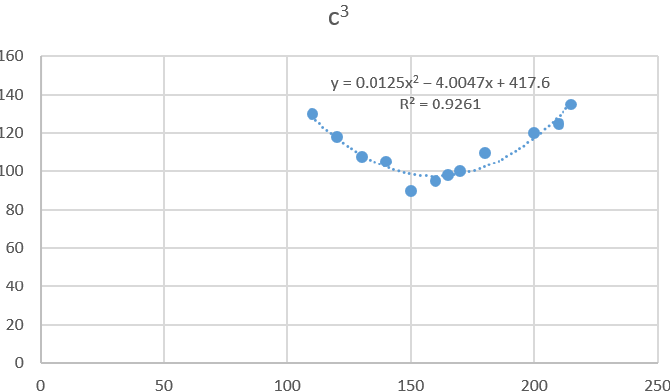
Figure 2. Analytical cost dependency on the size of the stock of the second type.